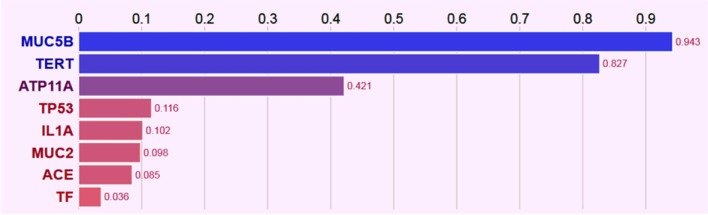
Bar plot of seed genes (MUC5B, TERT, and ATP11a) and predicted genes (TP53, IL1A, MUC2, ACE, and TF) normalized scores based on the gene–gene and gene–phenotype interactions.